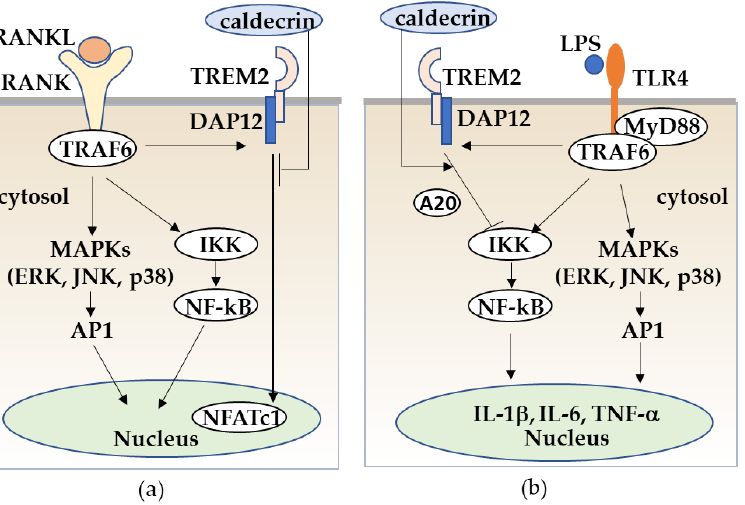
Figure 6. Caldecrin inhibits RANKL/RANK stimulated osteoclastogenesis from macrophages ( a ) and LPS/TLR4-stimulated macrophage activation through TREM-2 ( b ). ( a ) RANKL/RANK-stimulated osteoclast differentiation from macrophages is promoted with the activation of MAPKs, NF- κB, and the TREM - 2/DAP12 axis. Caldecrin inhibits the RANKL/RANK/TRAF6 co -stimulatory TREM -2/DAP12 signal which is critical for NFATc1 activation. ( b ) LPS/TLR4 stimulates the TRAF6/NF-kB and MAPK pathways in macrophages, resulting in the activation of macrophages to M1 polarization with increased production of pro-inflammatory cytokines such as TNF- α, IL -1, and IL-6. Caldecrin inhibits LPS-induced M1 macrophage polarization through TREM-2/DAP12 signaling with the induction of A20.